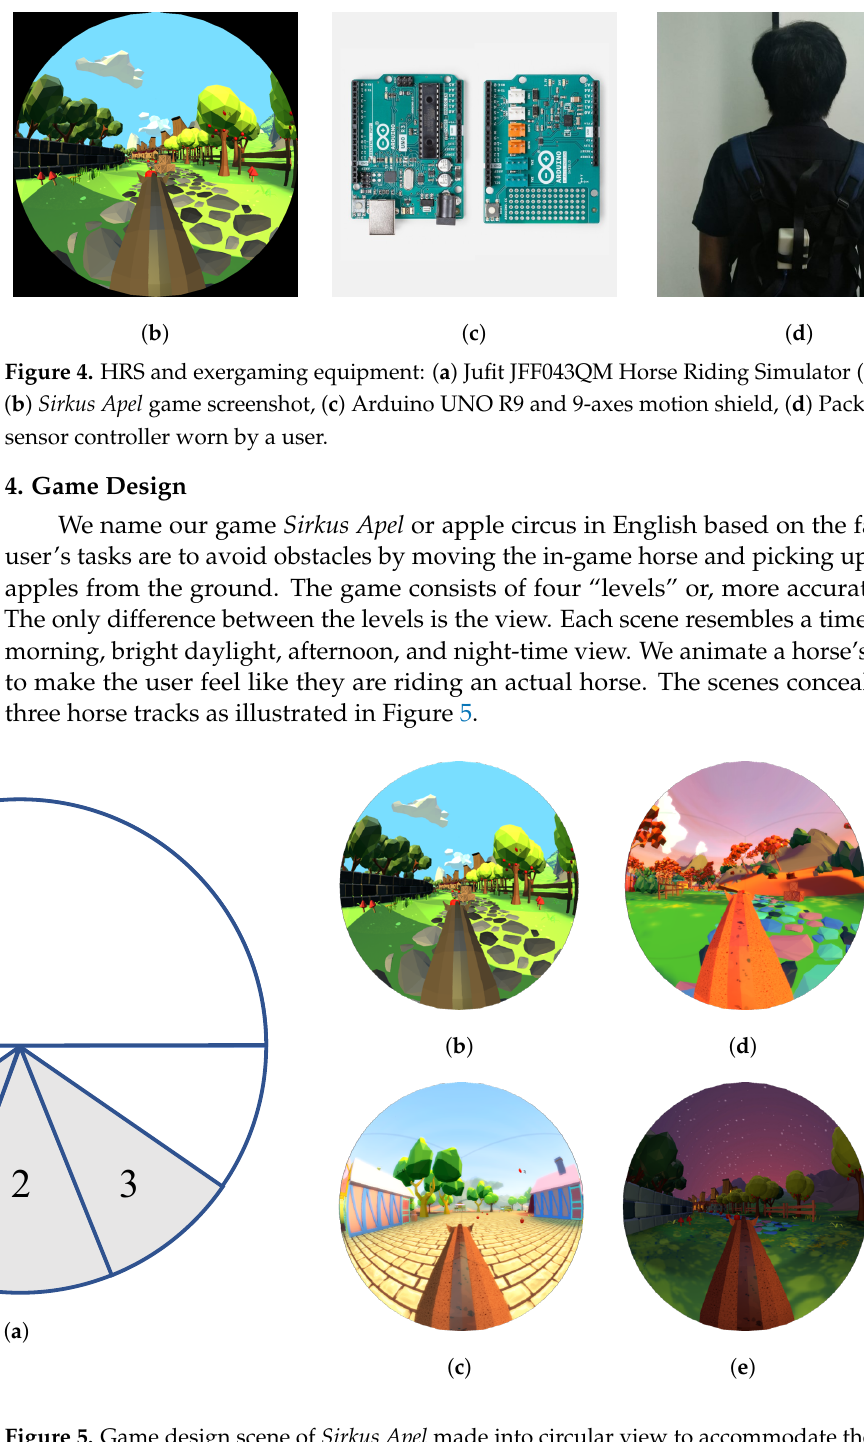
Figure 5. Game design scene of Sirkus Apel made into circular view to accommodate the iDome cur- vature: ( a ) Horse tracks illustration without game figures rendered, ( b ) Scene 1: morning, ( c ) Scene 2: bright daylight, ( d ) Scene 3: afternoon before sunset, ( e ) Scene 4: night-time